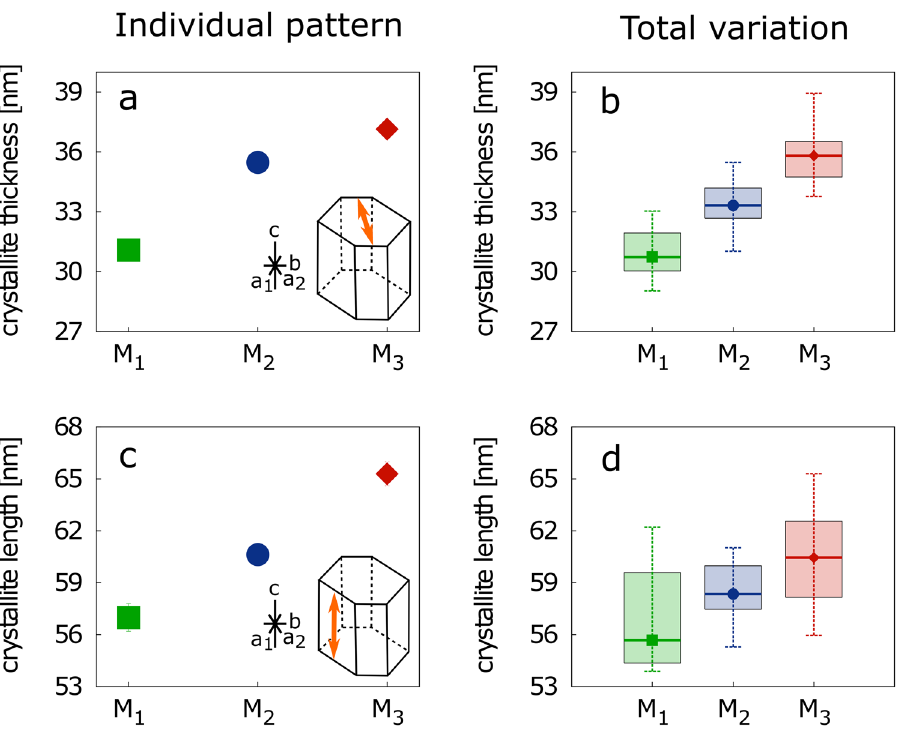
Figure 2. Computed crystallite thickness ( a,b ) and length ( c,d ) of: ( a,c ) 25-month old individual and ( b,d ) all studied samples. Diagrammatic representation (inset) of a hydroxyapatite crystallite with orange arrow showing its (a) thickness and (c) length. Note: The error bars at (a,c) are smaller than the size of symbols.